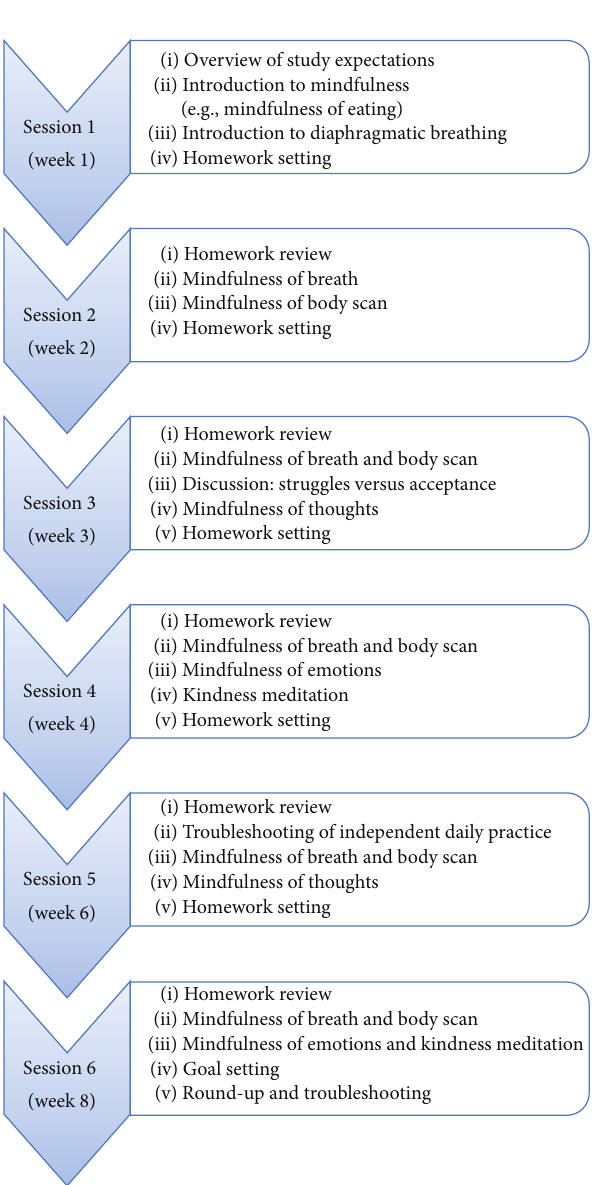
Figure 1: A summary of the mindfulness